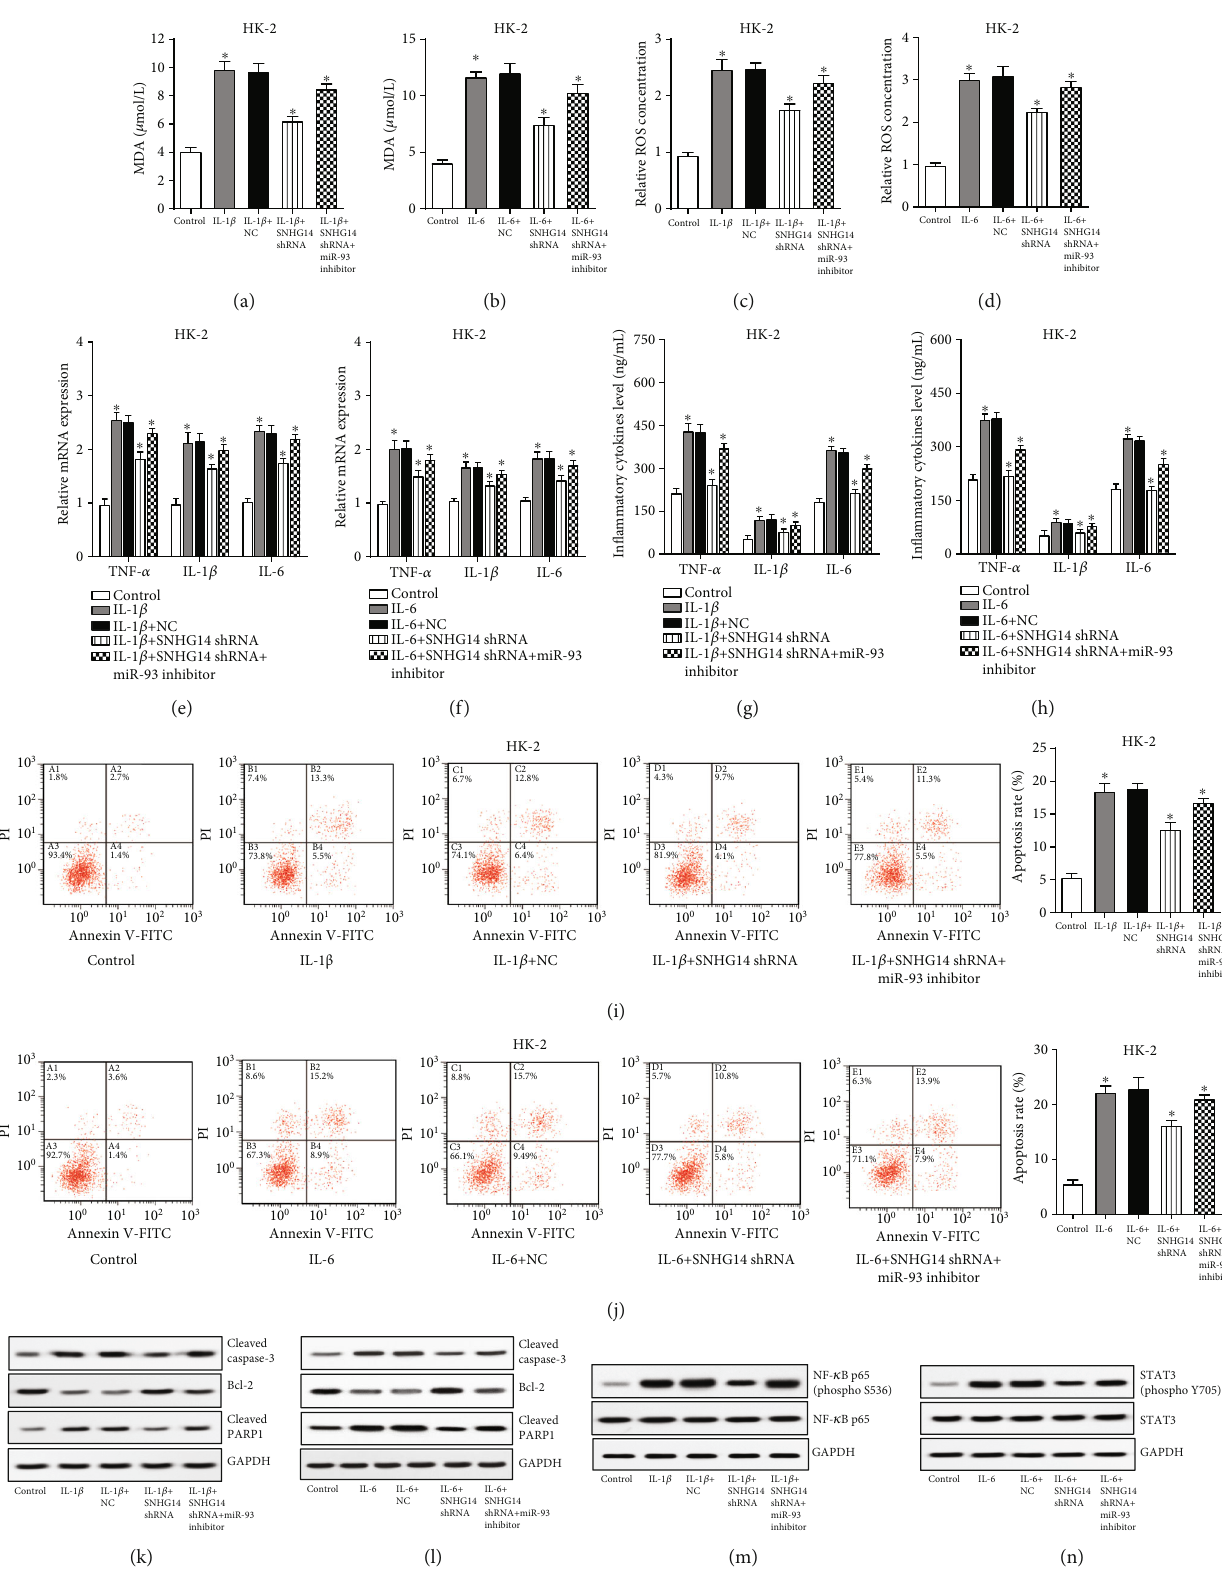
Figure 5: Silencing SNHG14 alleviates the cellular injury process of IL-1 β and IL-6 in HK-2 cells via miR-93. (a – n) HK-2 cells were treated with IL-1 β or IL-6 and then transfected with SNHG14 shRNAs and miR-93 inhibitor; oxidative stress (a – d), in fl ammation (e – h), and apoptosis (i – l) were assessed as described above; activation of NF- κ B and STAT3 signaling was tested by detecting relative proteins using western blot (m, n). Data were shown as mean ± SD , ∗ P < 0 : 05